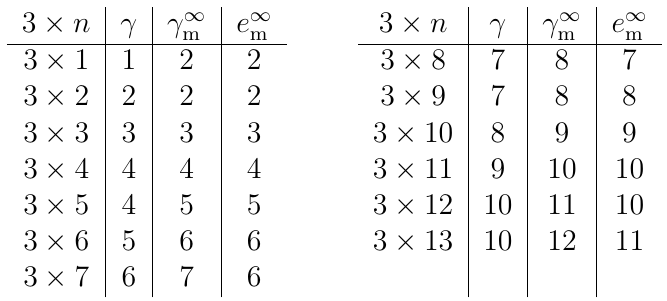
Table 1: Domination parameters for small n .